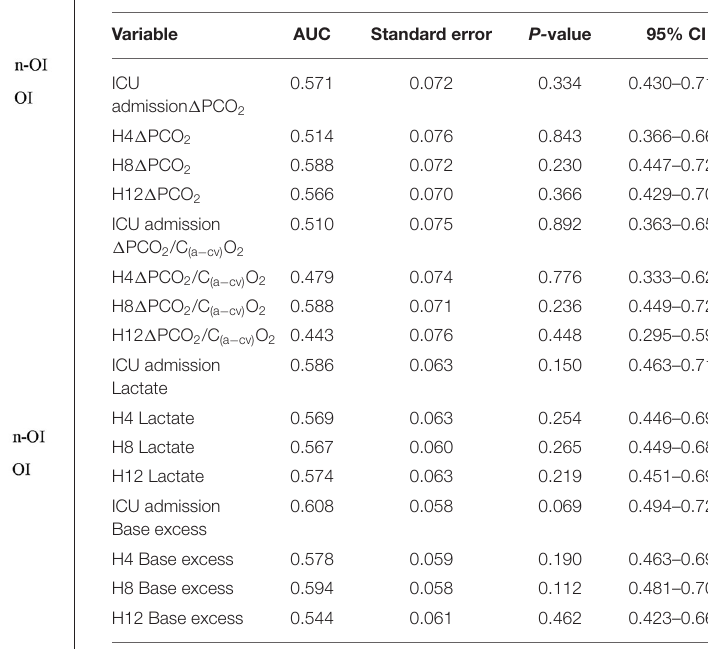
TABLE 3 | Area under the ROC curve of variables grouped into n-OI and OI.